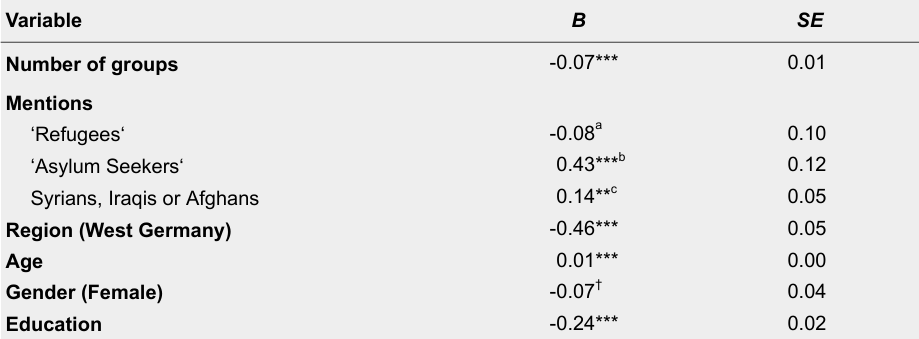
Note. OLS regression with N = 2,888, B are unstandardized coefficients. Groups with different superscripts differ with p <